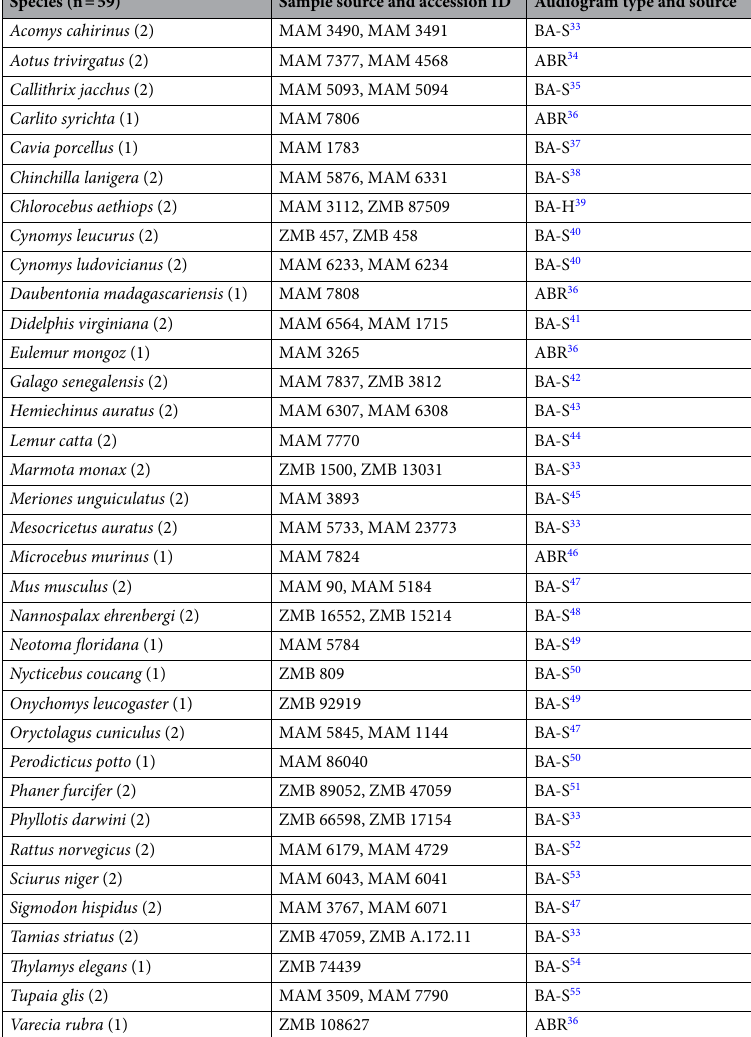
Table 1. Sample employed in the present study, with museum accession ID and audiogram source. MAM, Phyletisches Museum in Jena; ZMB, Museum für Naturkunde in Berlin; BA-S, speaker based